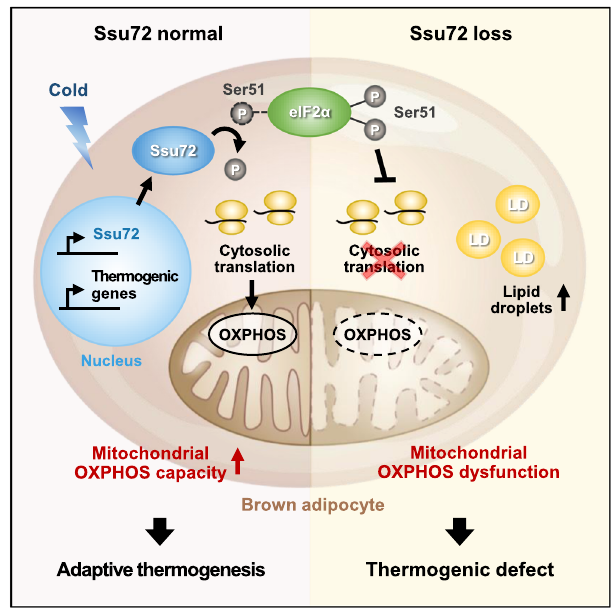
Fig. 8 | A proposed model for the role of Ssu72 in translation required for thermogenic adaptation of BAT. Ssu72, whose expression is increased in response to acute cold, acts as an eIF2 α phosphatase that dephosphorylates P-eIF2 α Ser51 and induces cytosolic translation of key thermogenic effectors such as OXPHOS. Through these mechanisms, mitochondria with normal oxidative capa- city further activate adaptive thermogenesis in brown adipocytes. In Ssu72- de fi cient brown adipocytes, cytosolic translation is attenuated by hyperpho- sphorylation of eIF2 α , resulting in mitochondrial dysfunction and thermogenic